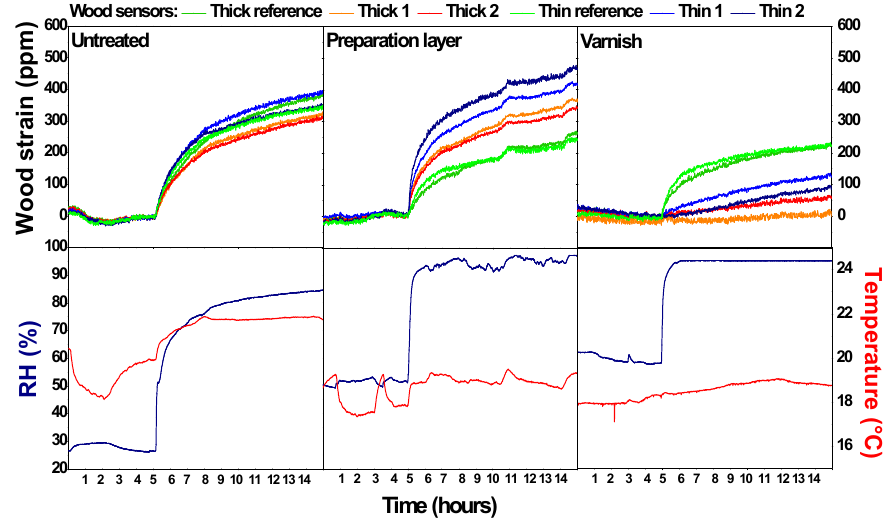
Figure 3. Dimensional response of the wood sensors for an RH step increase generated in a closed box in three different situations: (1) untreated wood, (2) wood with a preparation layer, and (3) wood with a preparation and varnish layer. The corresponding temperature and relative humidity conditions are shown for each situation.